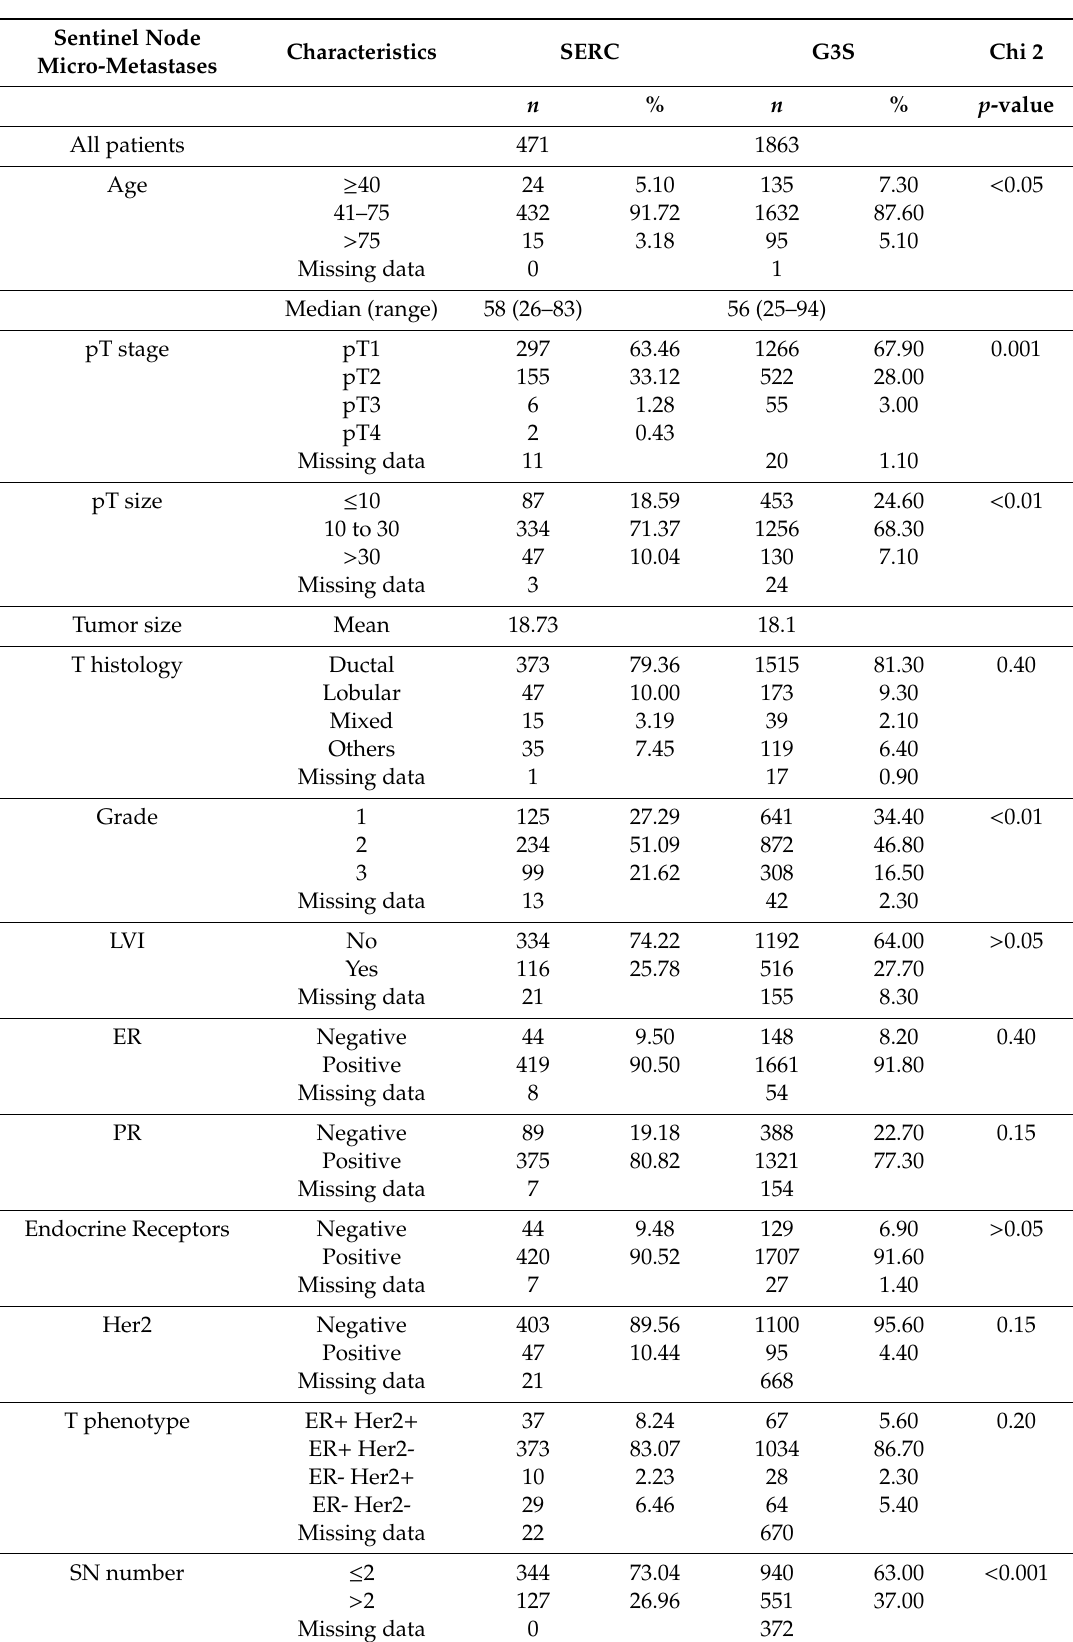
Table 1. Comparison of the SERC trial and the French cohort (G3S) populations. Sentinel